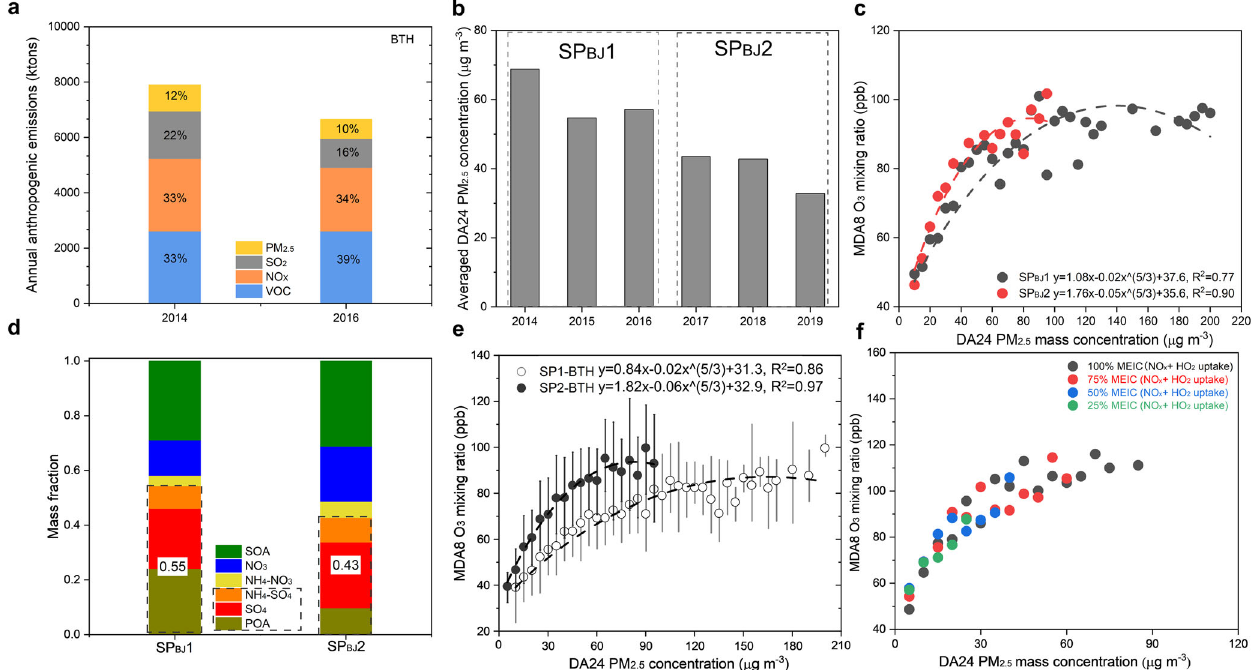
Fig. 2 O 3 and PM 2.5 , and related emissions in Beijing and BTH. a The 2014 and 2016 MEIC anthropogenic emissions in BTH; b the time series of the annual summertime average DA24 PM 2.5 in Beijing for each subperiod speci fi ed in the main text; c the O 3 -PM 2.5 relationship of Beijing for SP1 and SP2 with the non-linear fi tting; d the averaged aerosol mass fraction for each subperiod in Beijing. (Black dash box indicates SAP compounds. The number in each column indicates the SAP mass fraction); e The O 3 vs PM 2.5 relationship of main urban cities in BTH for SP1 and SP2 with the non-linear fi tting (The error bar indicates 25-75% data range); f The O 3 vs PM 2.5 relationship for different simultaneous emission abatement scenarios based on CMAQ simulations with NO x and HO 2 uptake for SP BJ 1 to 0.05 SP BJ 2 indicating the enhanced O 3 suppression by PM 2.5 , and (3) the O 3 -PM 2.5 relationship in SP BJ 1 and SP BJ 2 were similar after adjusting for the variability of measured SAP mass fraction in Beijing (Fig. 2d for aerosol composition mass fraction, Supplementary Fig. 3 for O 3 -PM 2.5 non-SAP relationship, and Method 2 for the aerosol composition measurements). The enhanced (VOCs + NO x ) emission fraction due to the control policies of SP BJ 2 is the dominant reason for the increased O 3 -PM 2.5 linear slopes (Fig. 2a), as in NYC. Considering Beijing extreme air pollution episodes as frequently being in fl uenced by regional transport from BTH 27 , these O 3 -PM 2.5 relationships in Beijing also represent a regional phenomenon in the BTH region (Fig. 2e) and re fl ect a complicating consideration in the current regional emission abatements with greater SO 2 and PM 2.5 reduction. Regional equal percentage emission reductions Beijing ’ s PM 2.5 maximums during SP BJ 2 are located near the MTP for this period. This implies that it is possible to reduce O 3 and PM 2.5 together following their relationship line (Fig. 2c, the red line) without encountering the O 3 enhancement that may occur with PM 2.5 reduction alone. Community Multiscale Air Quality (CMAQ) model simulations (Fig. 2f and Supplementary Fig. 4) veri fi ed this possibility by keeping the fraction of each specie emission (PM 2.5 , SO 2 , VOCs and NO x ) constant while imposing emission reductions, a strategy named “ regional equal percentage emission reductions ” , which also avoids further increased O 3 -PM 2.5 linear slope observed under the controls targeting mainly SO 2 and PM 2.5 emissions. As mentioned above, the increased O 3 -PM 2.5 linear slope indicates less O 3 reduction than PM 2.5 as in NYC. Under regional equal percentage emission reductions, the required BTH regional emission reductions based on the 2019 annual emissions were about (1) 42% to achieve the 2019 Beijing top5% DA24 PM 2.5 reaching the concentration levels of the 2001